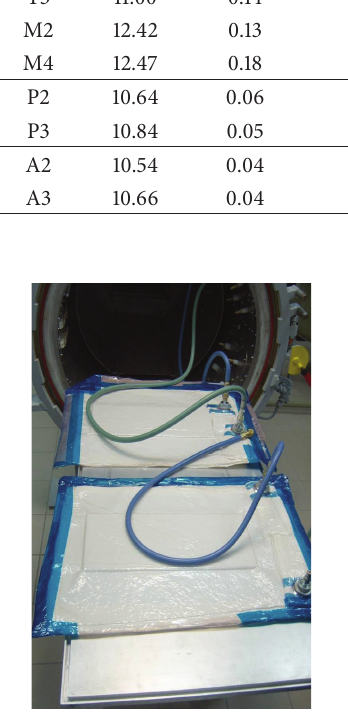
Figure 1: Vacuum packages before transport to